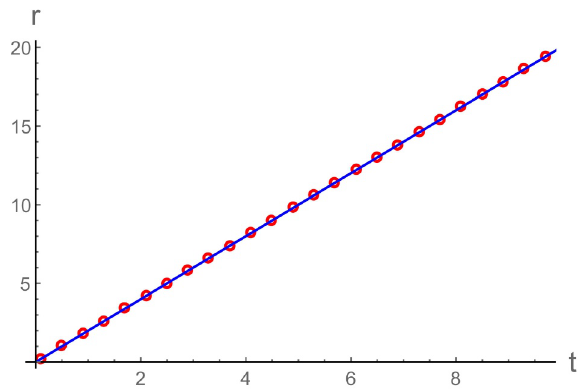
Figure 14 . Lorentzian initial data exhibits factorial growth for the series coefficients. Here we show r as defined in (F.3) vs. t for α = 1